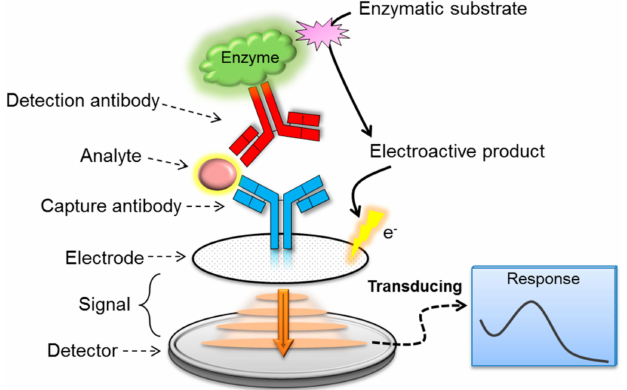
Figure 1. Basic analytical principle of electrochemical